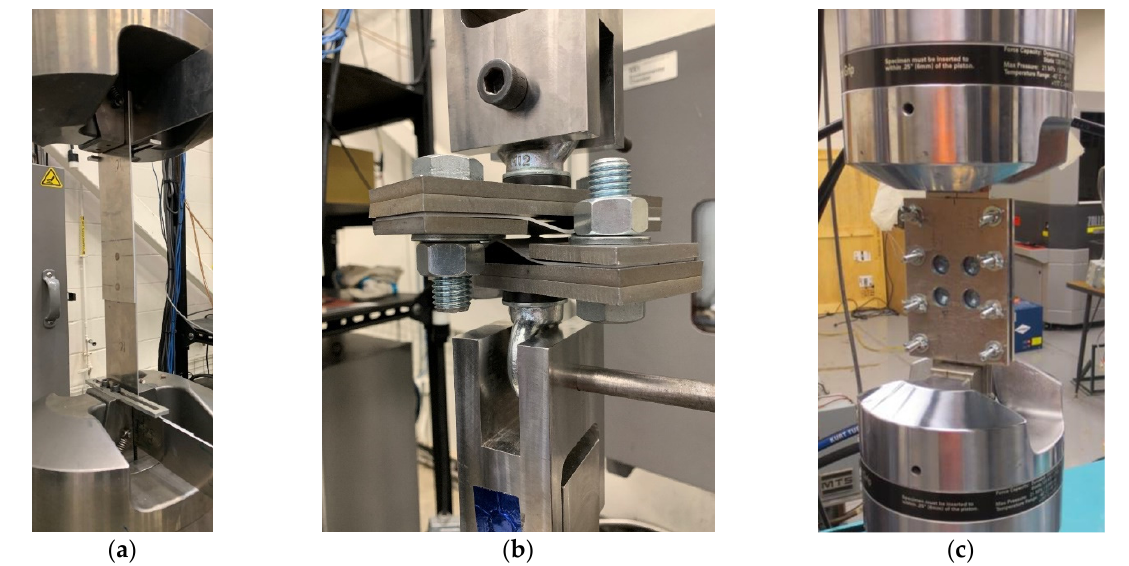
Figure 7. Mechanical test setups: ( a ) NASM-1312-4 test setup, ( b ) ISO-14272 test setup, and ( c ) NASM-1312-21 test setup.